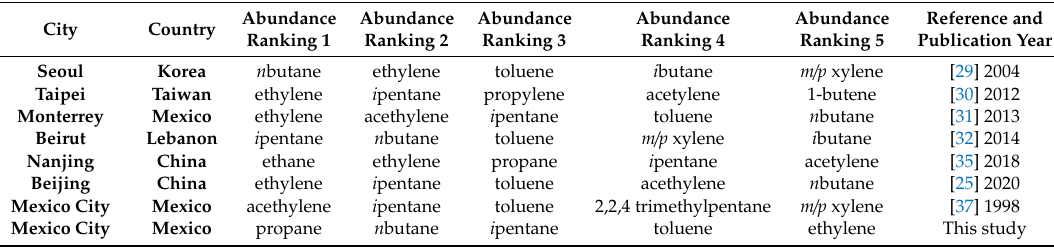
Table 3. Comparison of most abundant volatile organic compounds (VOCs) in exhaust emissions in tunnel studies.